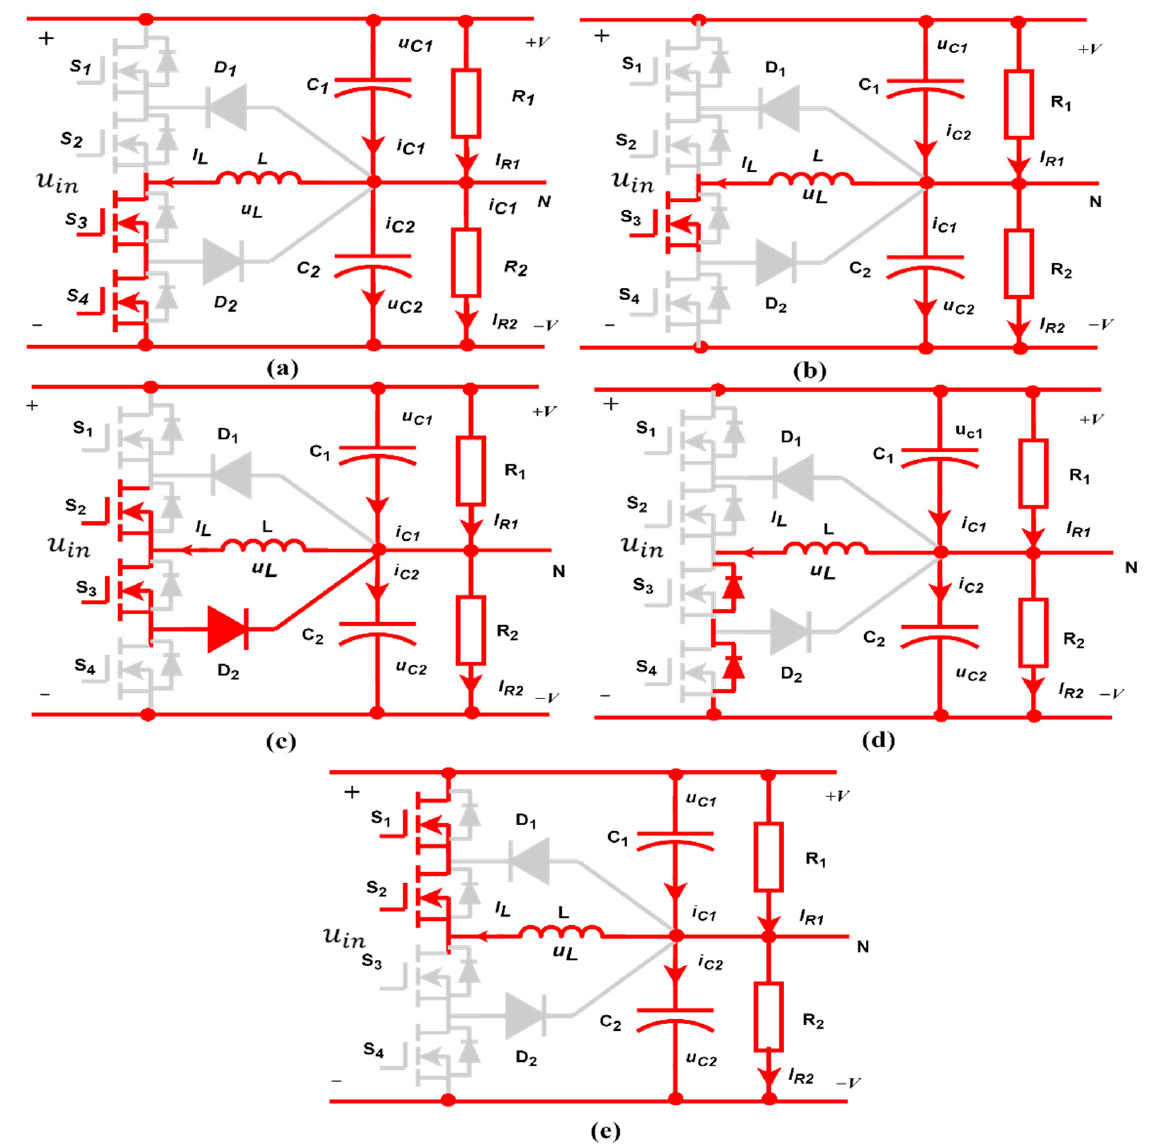
Figure 8. Three-level balancing converter equivalent circuit under state II. ( a ) Mode-V. ( b ) Mode- VI. ( c ) Mode-VII. ( d ) Mode-VIII. ( e ) Mode-IX. The corresponding voltages are displayed in Figure